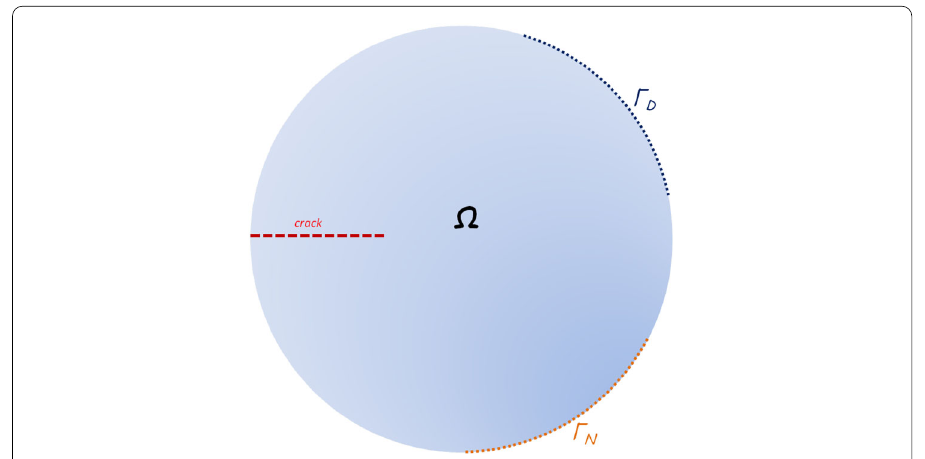
Fig. 6 Example of a cracked domain. Definition of notations used to label the domain and its boundaries